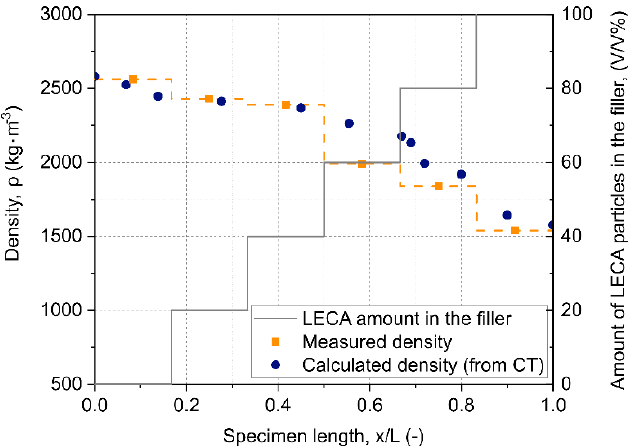
Figure 5. Density and amount of LECA particles in the filler according to the length of the 0-100 LECA graded sample.